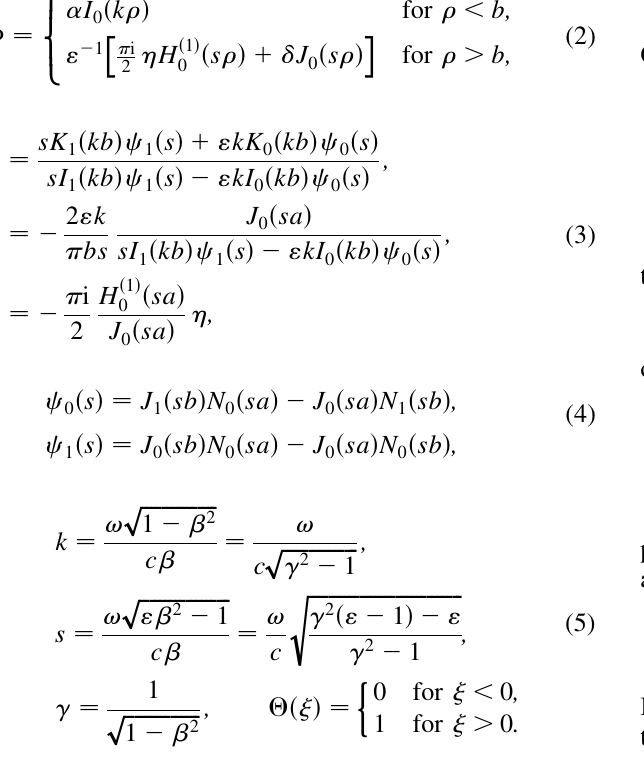
" ffiffiffiffiffiffiffiffiffiffiffiffiffiffiffiffiffiffiffiffiffiffiffiffiffiffiffiffiffiffi